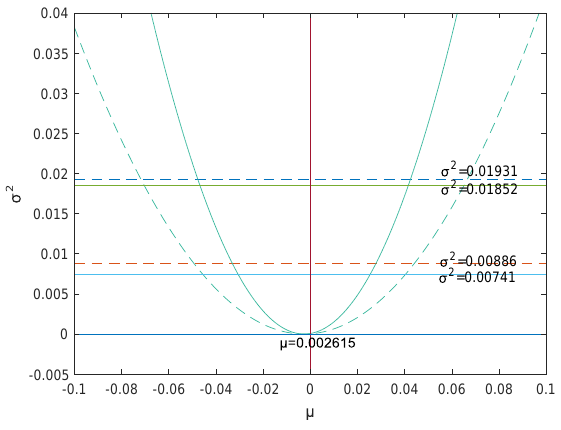
Figure 11. The contrast of two methods.